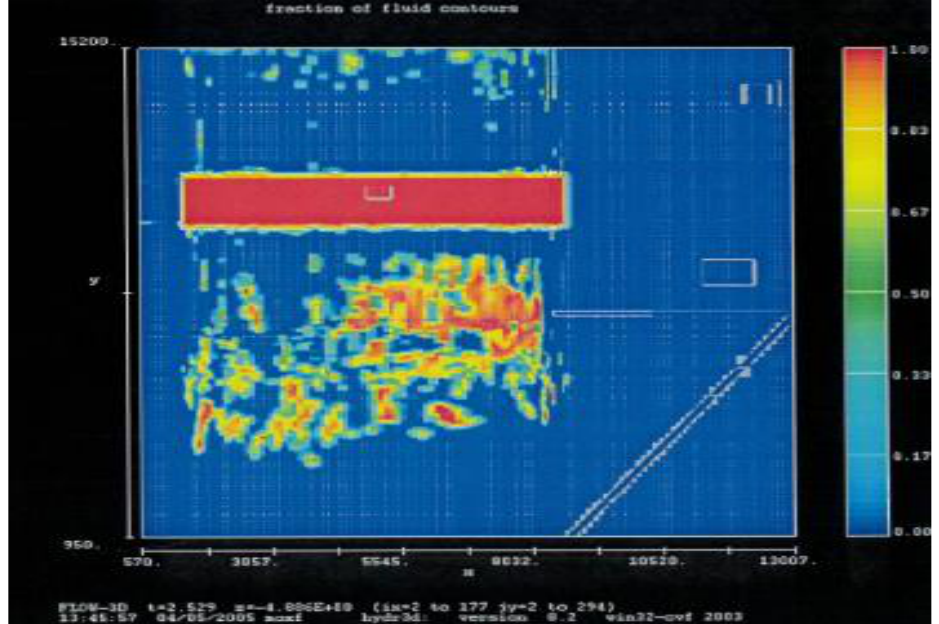
Figure 19. Aquifer fraction of fluid ff concentration at 4.08 m below the southern farm area surface 2.53 months after the monsoon season initiates. Aquifer water levels remain high at depth from earlier rainy season deposits. Color version added to [1], p. 367.